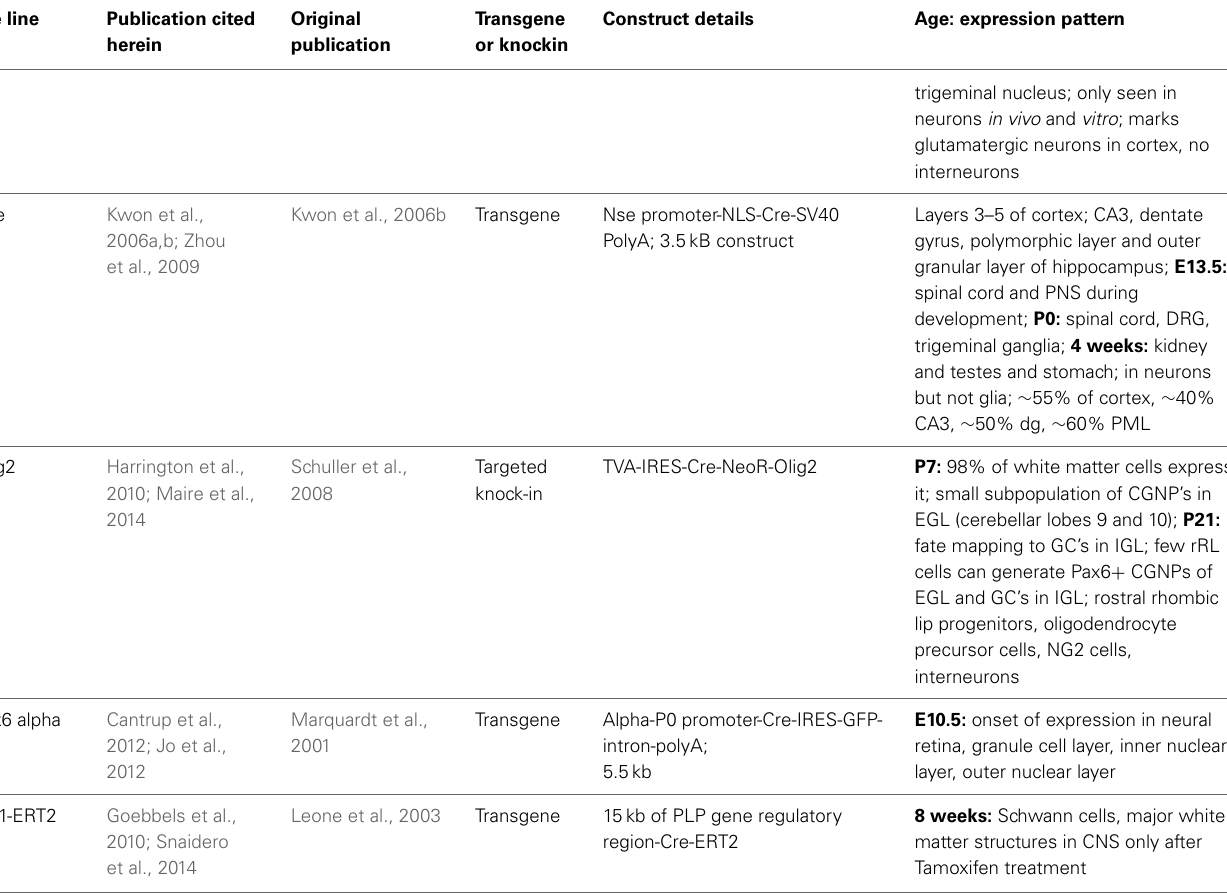
8 weeks: Schwann cells, major white matter structures in CNS only after Tamoxifen